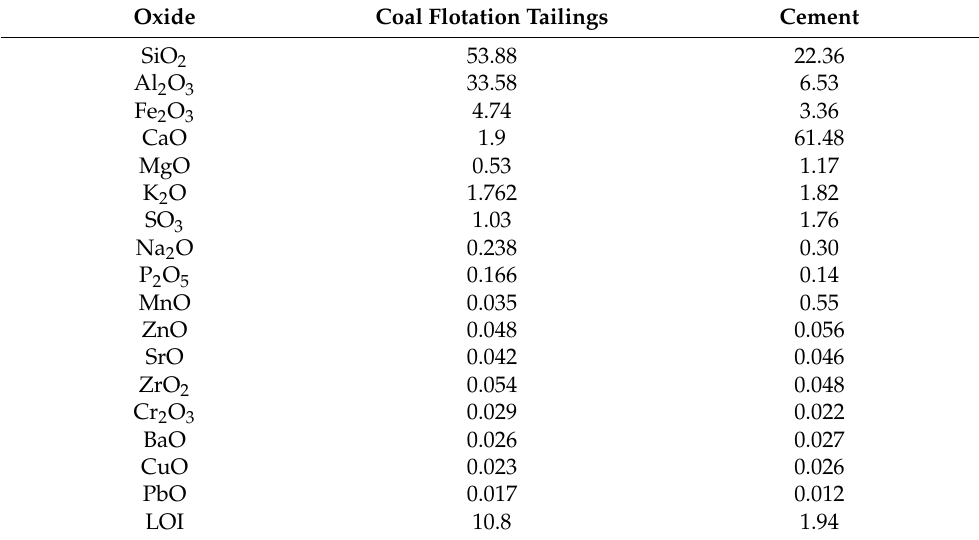
Table 1. Oxide content in raw materials